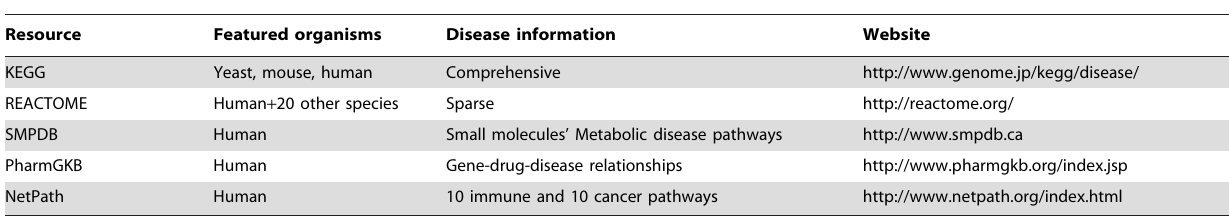
Table 1. Pathway databases with disease